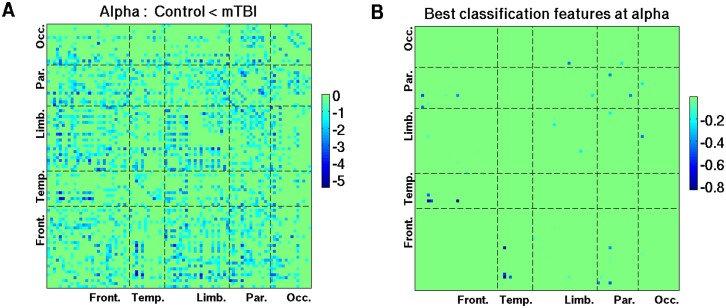
The 90 x 90 maps of increased phase synchrony at alpha frequencies in mTBI.(A) z-scores associated with the increases in connectivity in mTBI; and (B) connections cotributing to classification, robustrly across frequencies and subjects. Similar to Fig 7, panel A shows only the connections associated with the bootstrap ratio values less than -1. To compare the hyper-connectivity in mTBI at alpha frequencies with classification results, Panel B represents a matrix version of the 3D spatial pattern (Fig 5), which corresponds to the situation wherein 33 best features are used for prediction (see Fig 3).